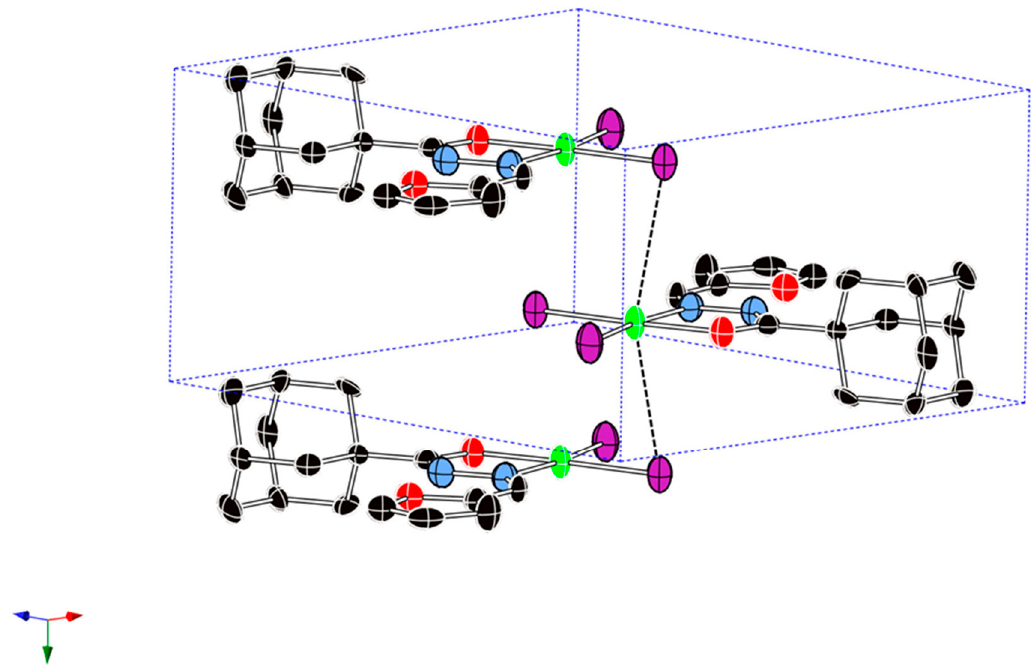
Figure 2. Crystal packing along the c-axis of 1 shows the distorted octahedron around copper, the thermal ellipsoid drawing of 50%.